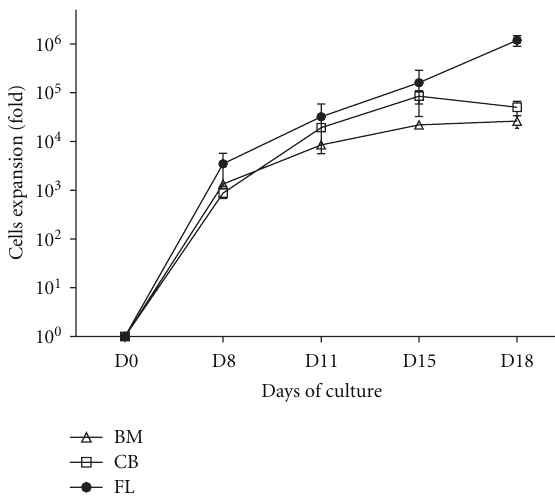
Figure 1: Amplification of CD34 + FL cells during erythroid di ff erentiation. CD34 + hematopoietic stem cells from fetal liver (FL) were grown in liquid culture according to the three-step protocol described in Section 2, and total cells were counted at the indicated times. Mean values with the standard deviation for three experiments are shown, and the results are compared to those for amplification of cells from cord blood (CB) and bone marrow (BM).